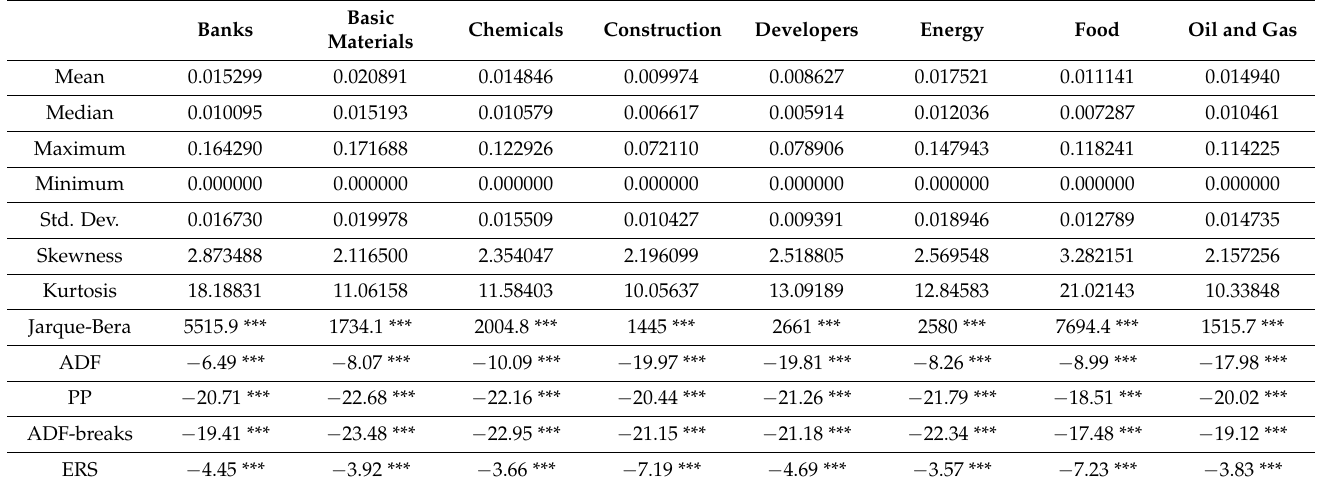
Table 2. Indicators of the descriptive statistics of volatility for the period of 1 January